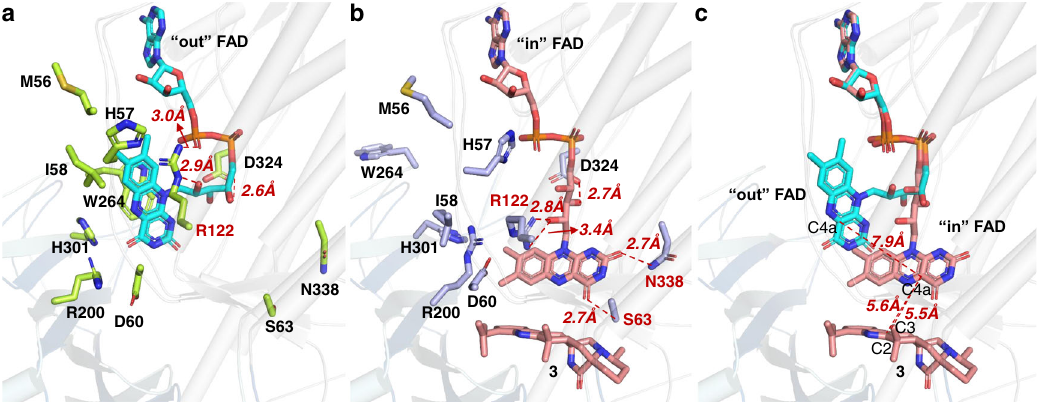
Fig. 4 Structural changes of the FAD-binding sites in CtdE upon substrate binding. a “ Out ” FAD-binding site. b “ In ” FAD-binding site. c Structural overlay of “ out ” FAD and “ in ” FAD-binding